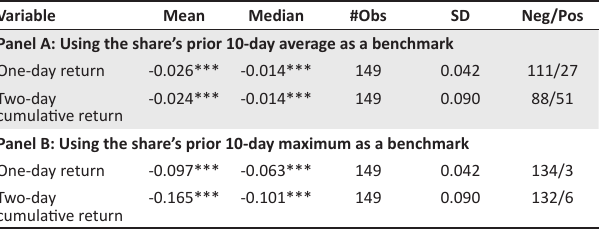
TABLE 4: The stock market’s reaction to secondary equity offering announcements. Variable